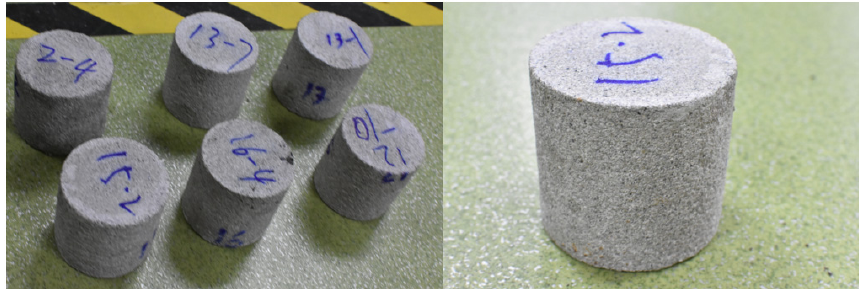
Figure 2. Sand specimen after grinding.